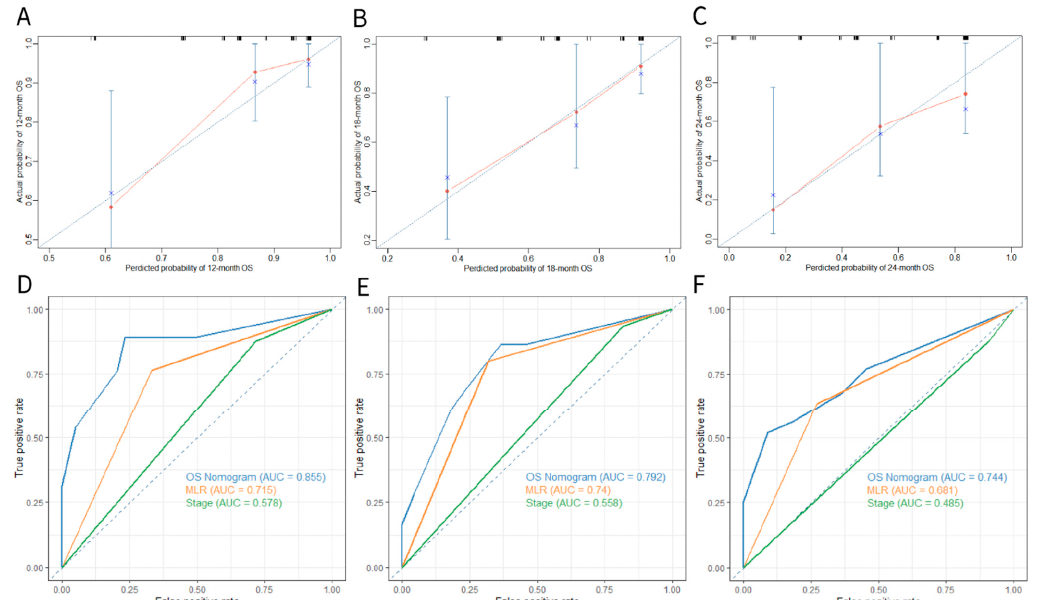
Figure 4. ( A – C ) The calibrate curves of 12-, 18-, and 24-month OS presented the consistency of predicted probabilities and actual observations. ( D – F ) The time-dependent ROC curves of 12-, 18-, and 24-month OS predicted by the OS nomogram, MLR and the TNM staging system respectively. Abbreviations: OS, overall survival; MLR, monocyte-to-lymphocyte ratio; TNM, tumor-node-metastasis; AUC, area under ROC curve.